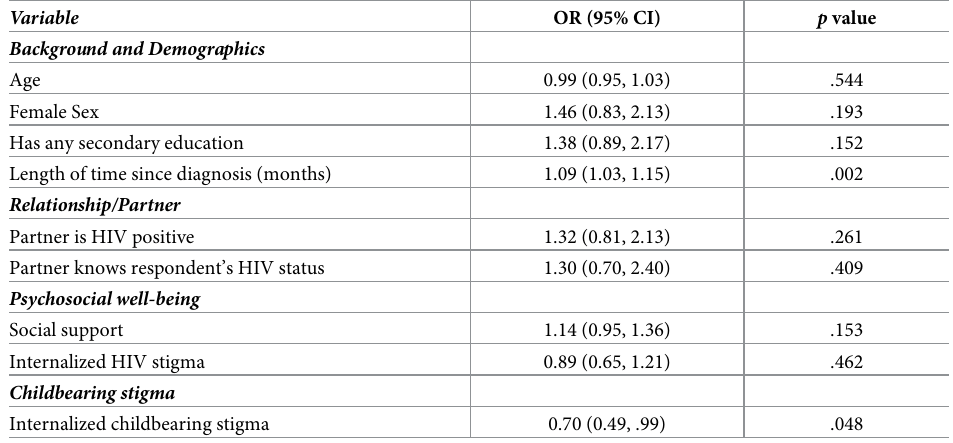
Table 3. Logistic regression of correlates of having discussed childbearing intentions with HIV